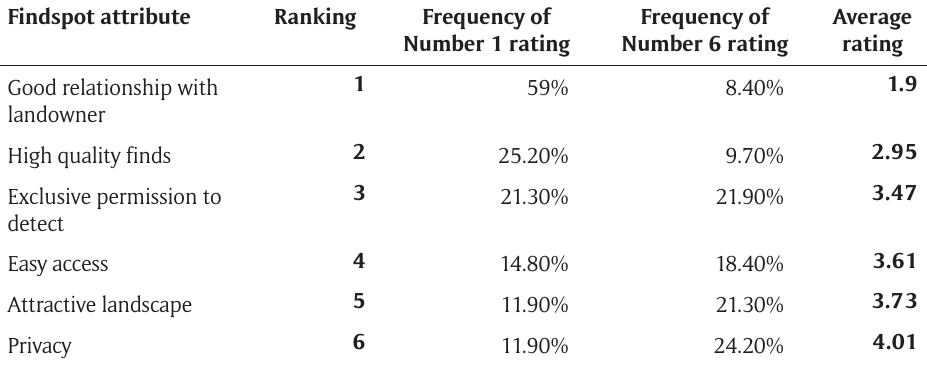
Table 1: Table representing how respondents ranked the importance of different findspot attributes (n =